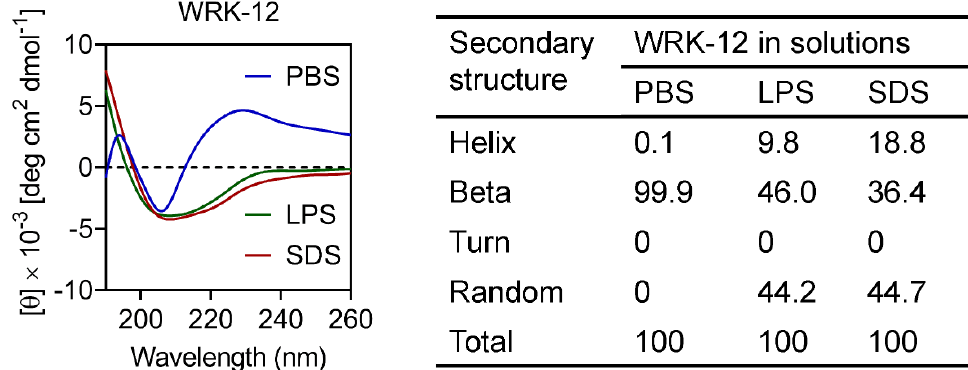
Figure 2. Circular dichroism (CD) spectra of WRK ‐ 12 in PBS (10 mM, pH 7.4), Lipopolysaccharide (LPS) (50 μ M) and SDS (50 mM). The values from three scans were averaged per sample, and the peptide concentrations were fixed at 100 μ g/mL.